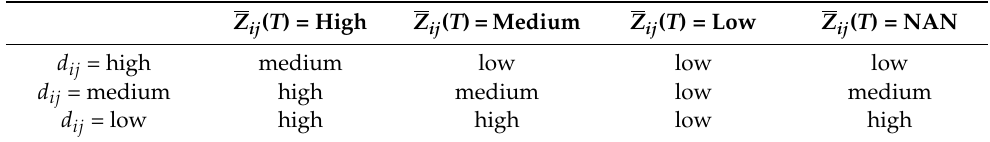
Table 2. The results of identification rules in different